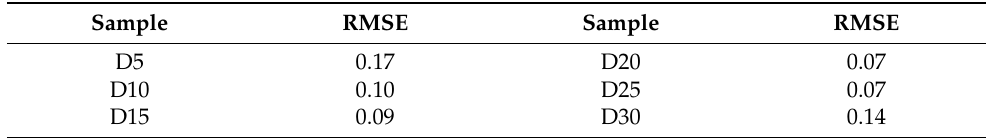
Table 6. RMSE for samples with different backing air cavity